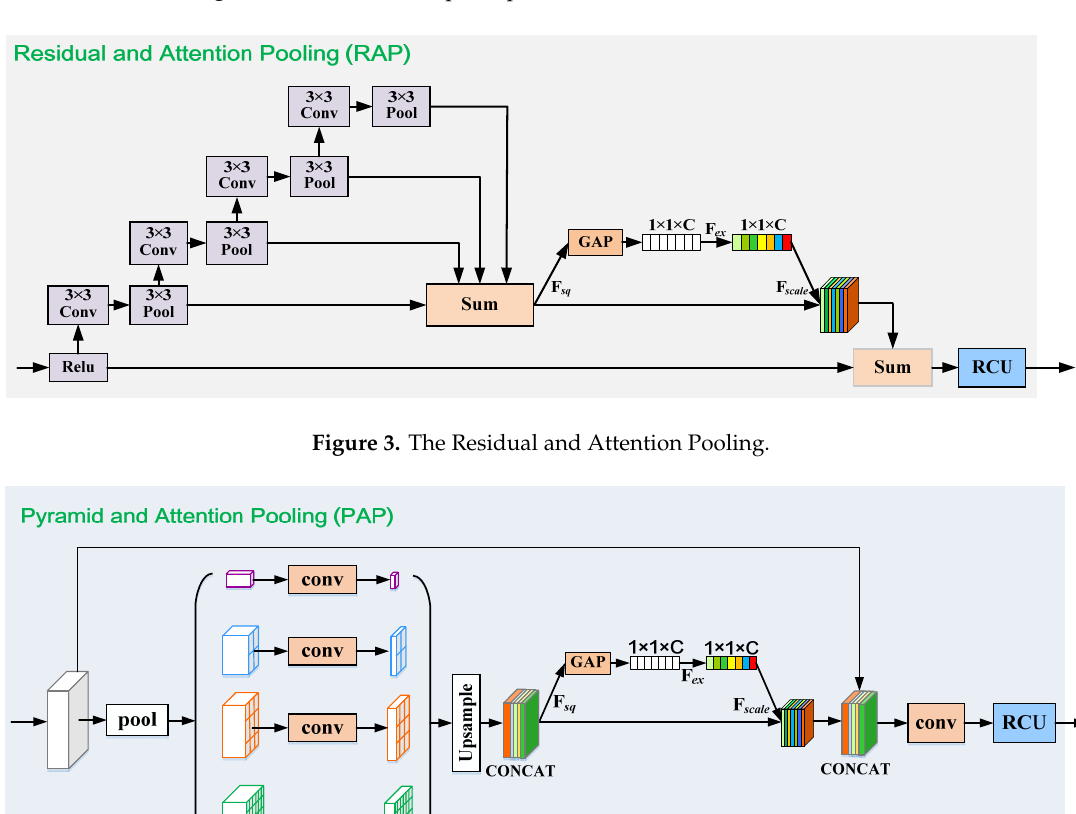
Figure 3. The Residual and Attention Pooling.